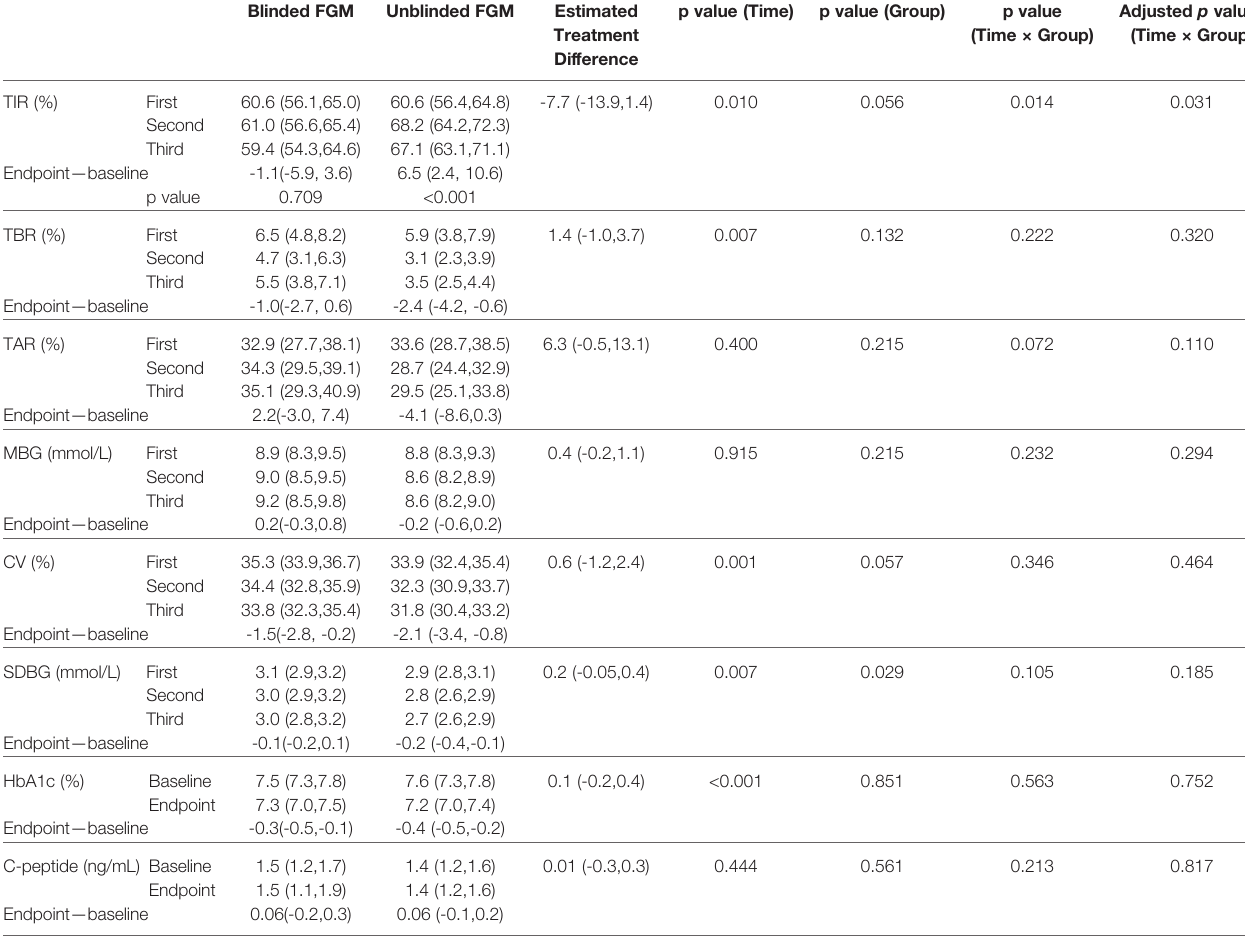
TABLE 2 | Changes of daily glycemic control in blinded and unblinded FGMs. Blinded FGM Unblinded FGM Estimated